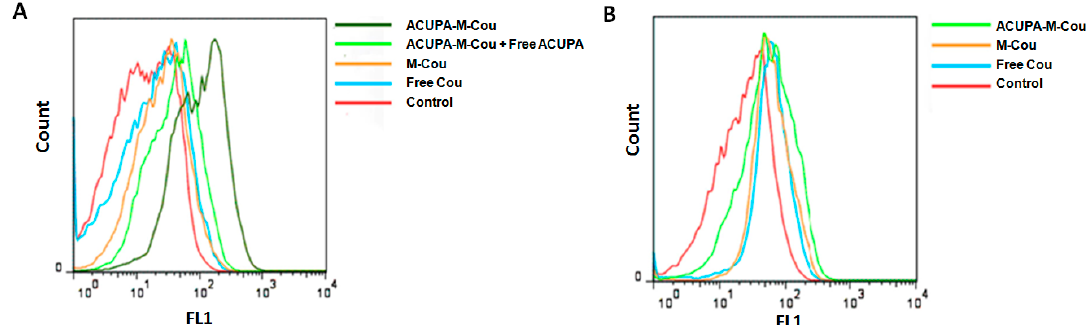
Figure 4. The fluorescence intensities in LNCaP and PC-3 cells treated with ACUPA-M-Cou (coumarine-6 loaded ACUPA modified micelles). ( A ) The fluorescence intensities in LNCaP cells respectively incubated with ACUPA-M-Cou, ACUPA-M-Cou plus free ACUPA, M-Cou (coumarine-6 loaded micelles), free coumarine-6, and PBS. Moreover, the mean fluorescence intensities of each group are quantified; ( B ) The fluorescence intensities in PC-3 cells respectively treated with ACUPA-M-Cou, M-Cou, free coumarine-6, and PBS. Moreover, the mean fluorescence intensities of each group are quantified.